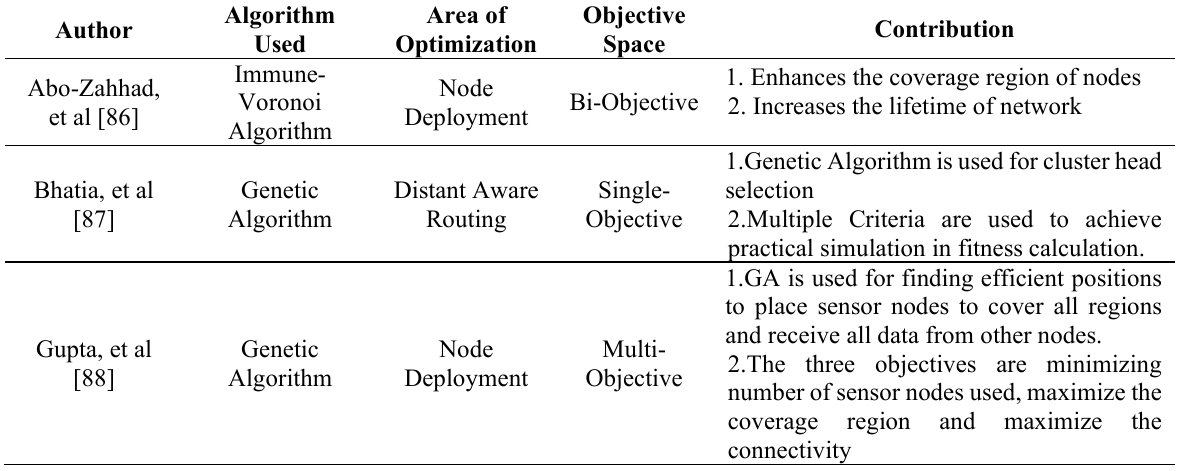
Table 5. State of Art on Evolutionary Algorithms in the domain of Wireless Sensor